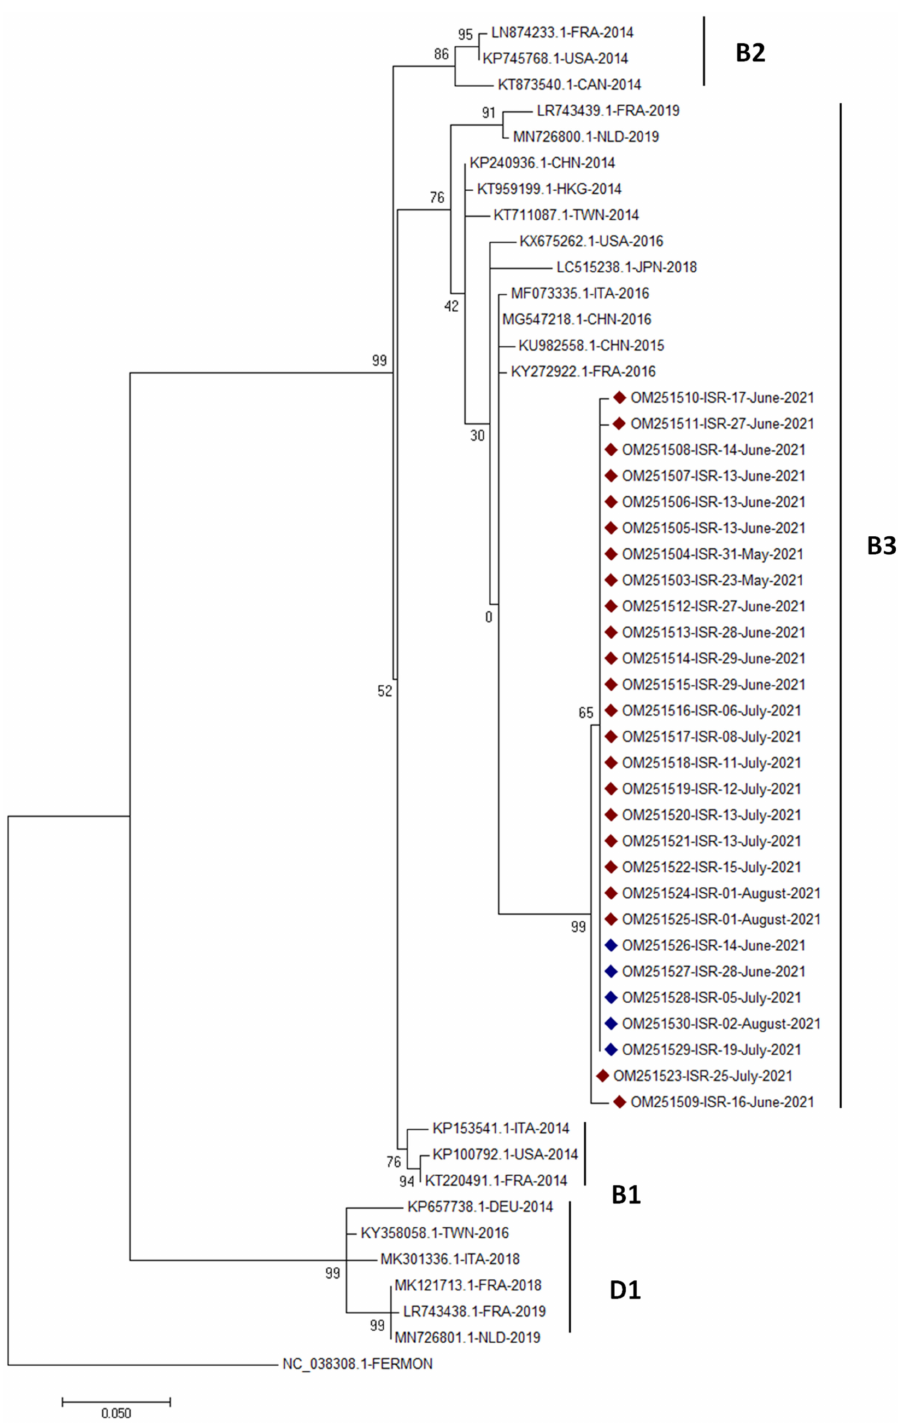
Figure 2. Phylogenetic analysis of EV-D68 sequences obtained in this study. A sequence of 280 nu- cleotides from EVD68 VP1 gene was amplified and analyzed by constructing a phylogenetic dendro- gram together with representing sequences from different strains. The dendrogram was generated using MEGA 7 [21] with 1000 bootstrap replications. Bootstrap values are shown at the branch nodes. The reference strains are each labeled with their accession number, country of origin and year of collection. The samples from Israel were marked in color, as follows: clinical samples in red and sewage samples in